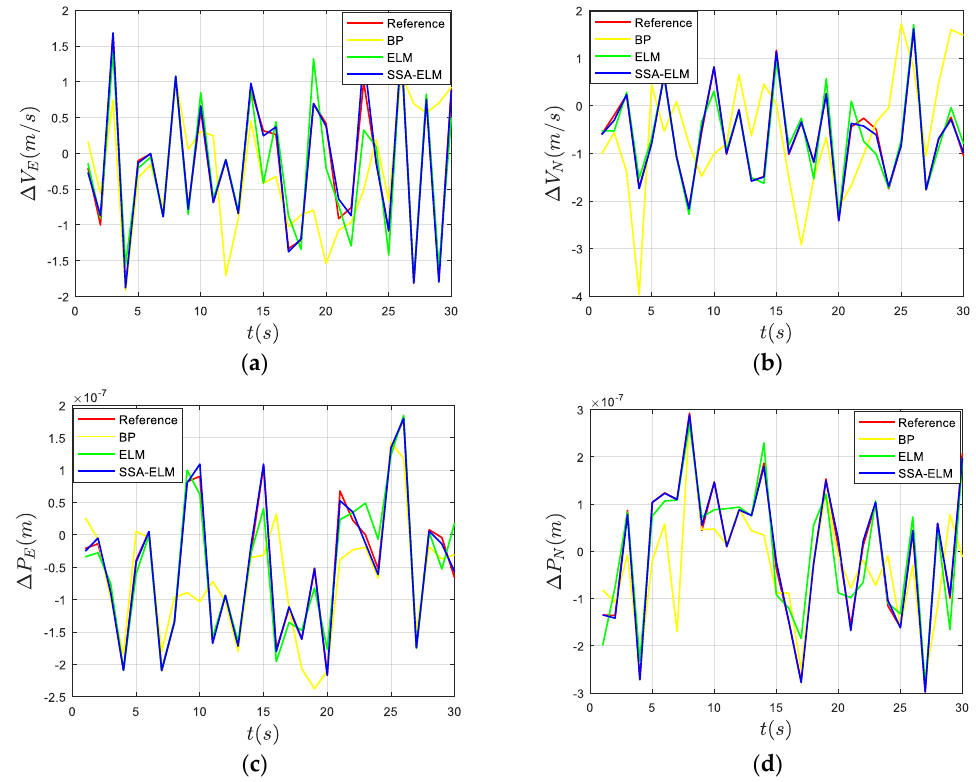
Figure 11. Prediction of the velocity and position differences of different methods during the third interruption: ( a ) east velocity difference prediction; ( b ) north velocity difference prediction; ( c ) east position difference prediction; ( d ) north position difference prediction. Table 8. RMSE and MAE of the velocity and position differences of different methods during the third interruption.